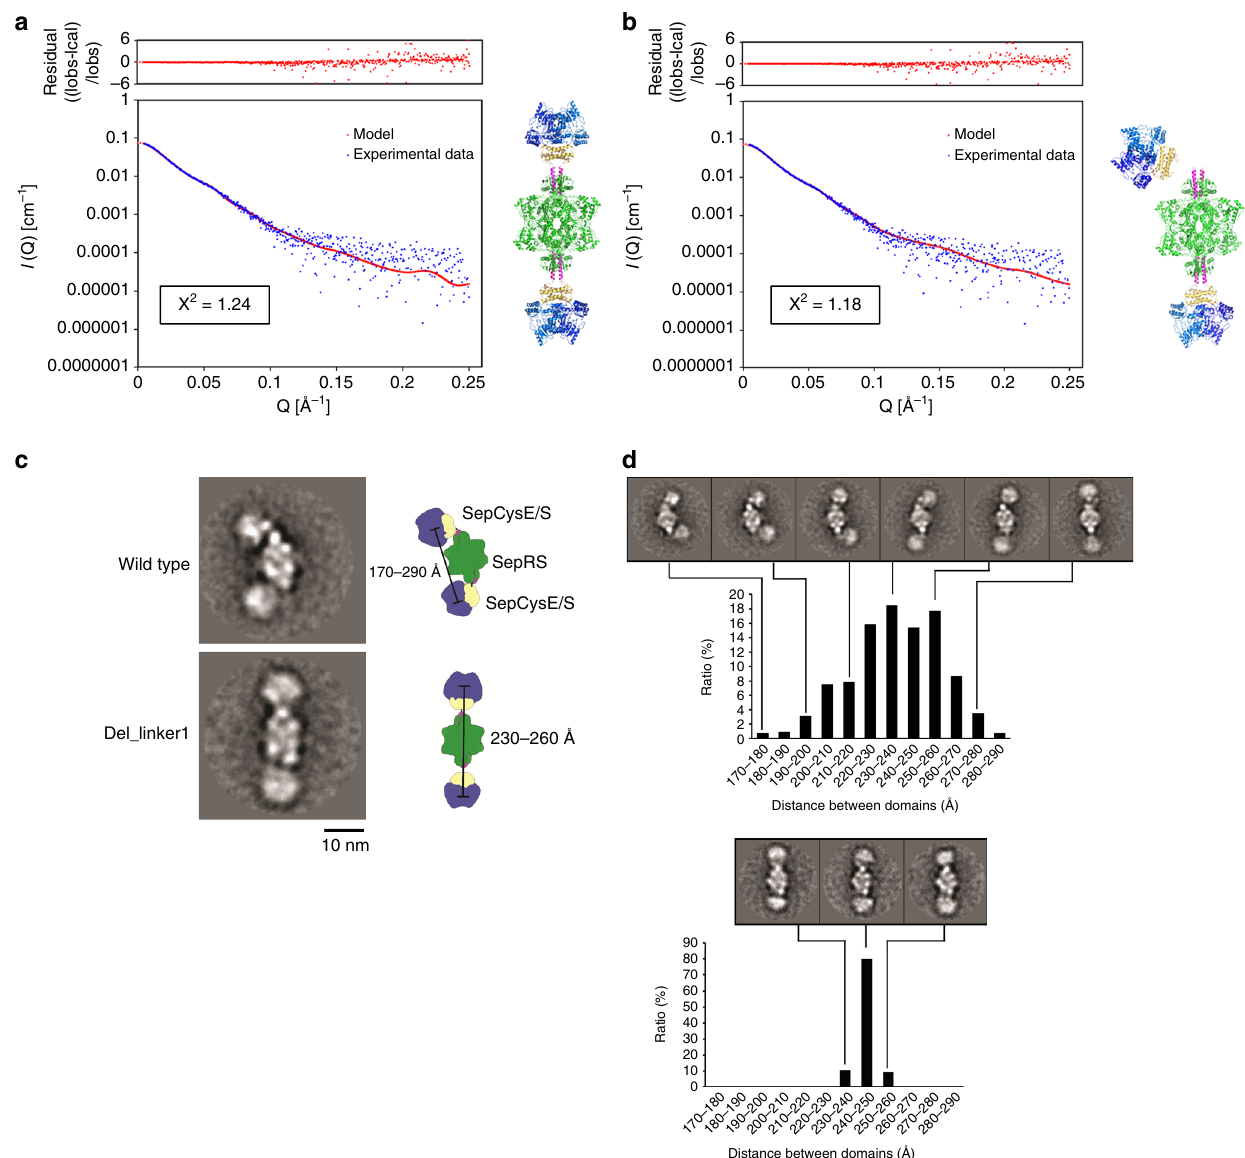
Fig. 4 SAXS and EM analyses showing the domain fl exibility of the transsulfursome. a , b SAXS analysis of the transsulfursome. Experimental scattering data (blue) fi t well to a theoretical curve (red) calculated from the combined model from crystal structures. Fitting is not sensitive to the azimuth or tilt angles of the (SepCysE(NTD)-SepCysS) domains. a Best fi tted “ straight model ” with center-to-center distance of end domains (SepCysE(NTD)-SepCysS) of about 240 Å. b Tilted models fi t well as long as (SepCysE(NTD)-SepCysS) is within an appropriate distance from SepRS. Given here is one example of a well- fi tted “ bent model. ” c , d Negative stain EM analysis of wild and mutant (del_linker1) transsulfursome. c Selected class-average of a wild type transsulfursome bent (above) and a typical mutant(del_linker1) straight conformation (bottom) (scale bars, 10 nm), with interpretative cartoons showing SepRS, SepCysS and SepCysE in green, blue and khaki, respectively. The cartoons were obtained after graphically mapping a low-pass fi ltered 3D model of each component into the respective class average. Rulers indicate the distribution range of the total distance between the SepCysE-SepCysS domains at opposite ends of the complex. d Center-to-Center distance distribution between the SepCysE-SepCysS domains measured for all class-averages of the wild type transsulfursome (above) and the mutant (del_linker1) (bottom) data set, respectively. Representative class averages are shown and marked by connecting lines. Each class average contains 60 – 140 single particles. Note that the two SepCysE-SepCysS domains tilt independent from each other and the complex can adopt thereby bent and S-shaped conformations. Typical micrographs and larger sets of class averages are shown in Supplementary Fig.